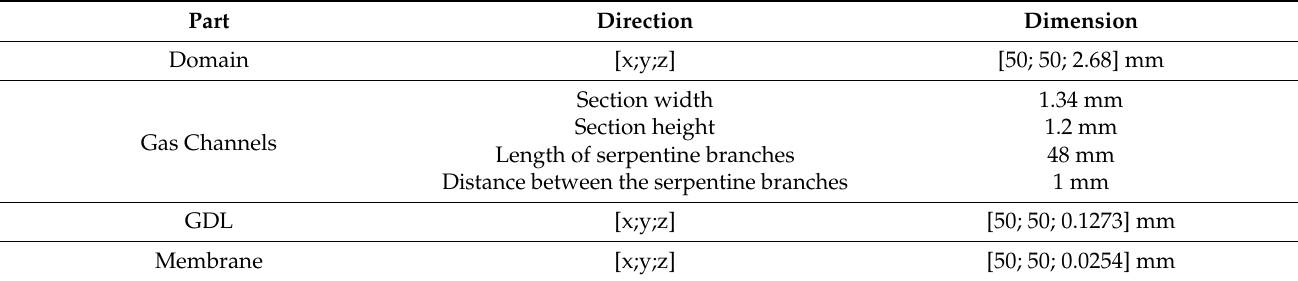
Figure 2. Mesh distribution in the anode gas channel (green, with anode bipolar plate removed for visualization) and in the cathode bipolar plate (grey). Table 5. Parameters of the electrochemical reactions.